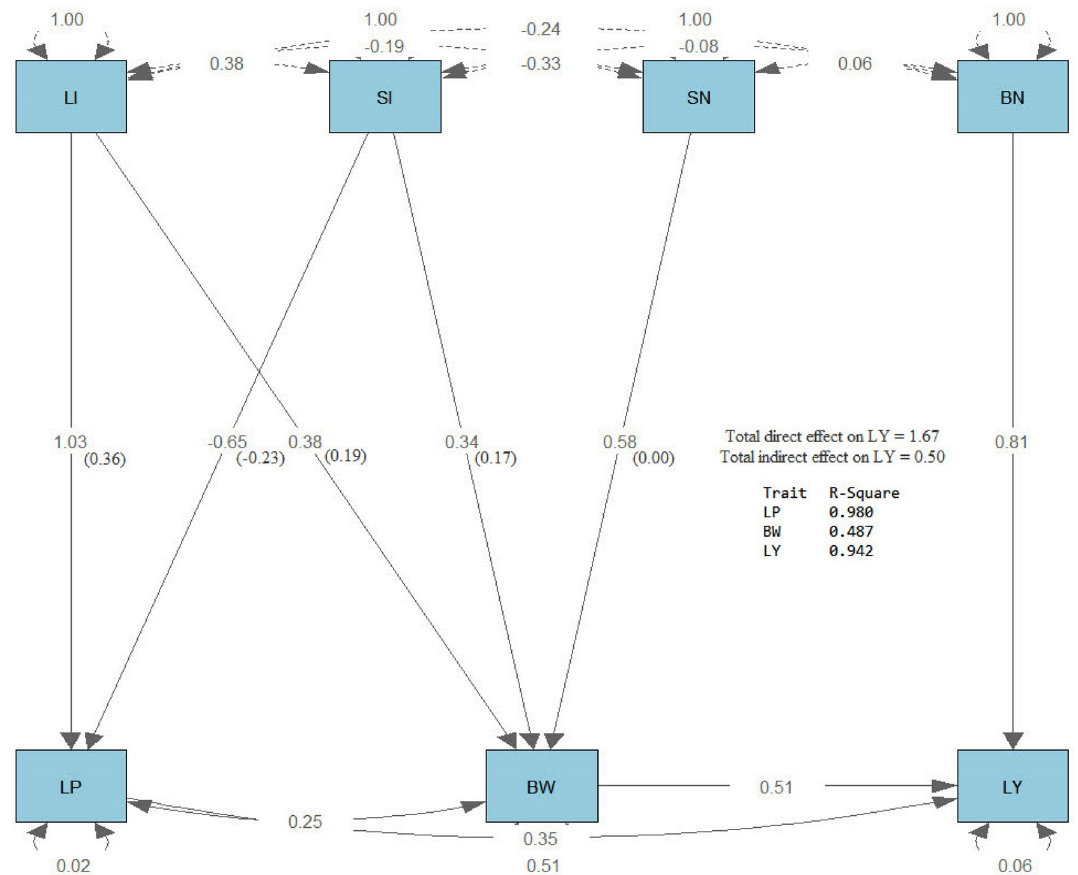
Figure 6. Path diagram of the direct and indirect effects of the studied traits in F4.